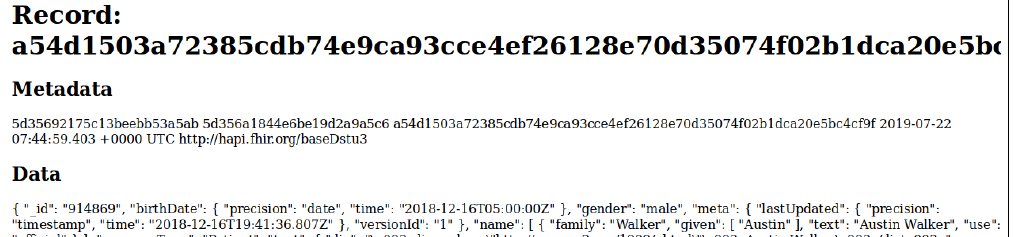
Figure 8. Example data record. The first field is the unique record id; the second field is the record metadata; the third field is the content of the